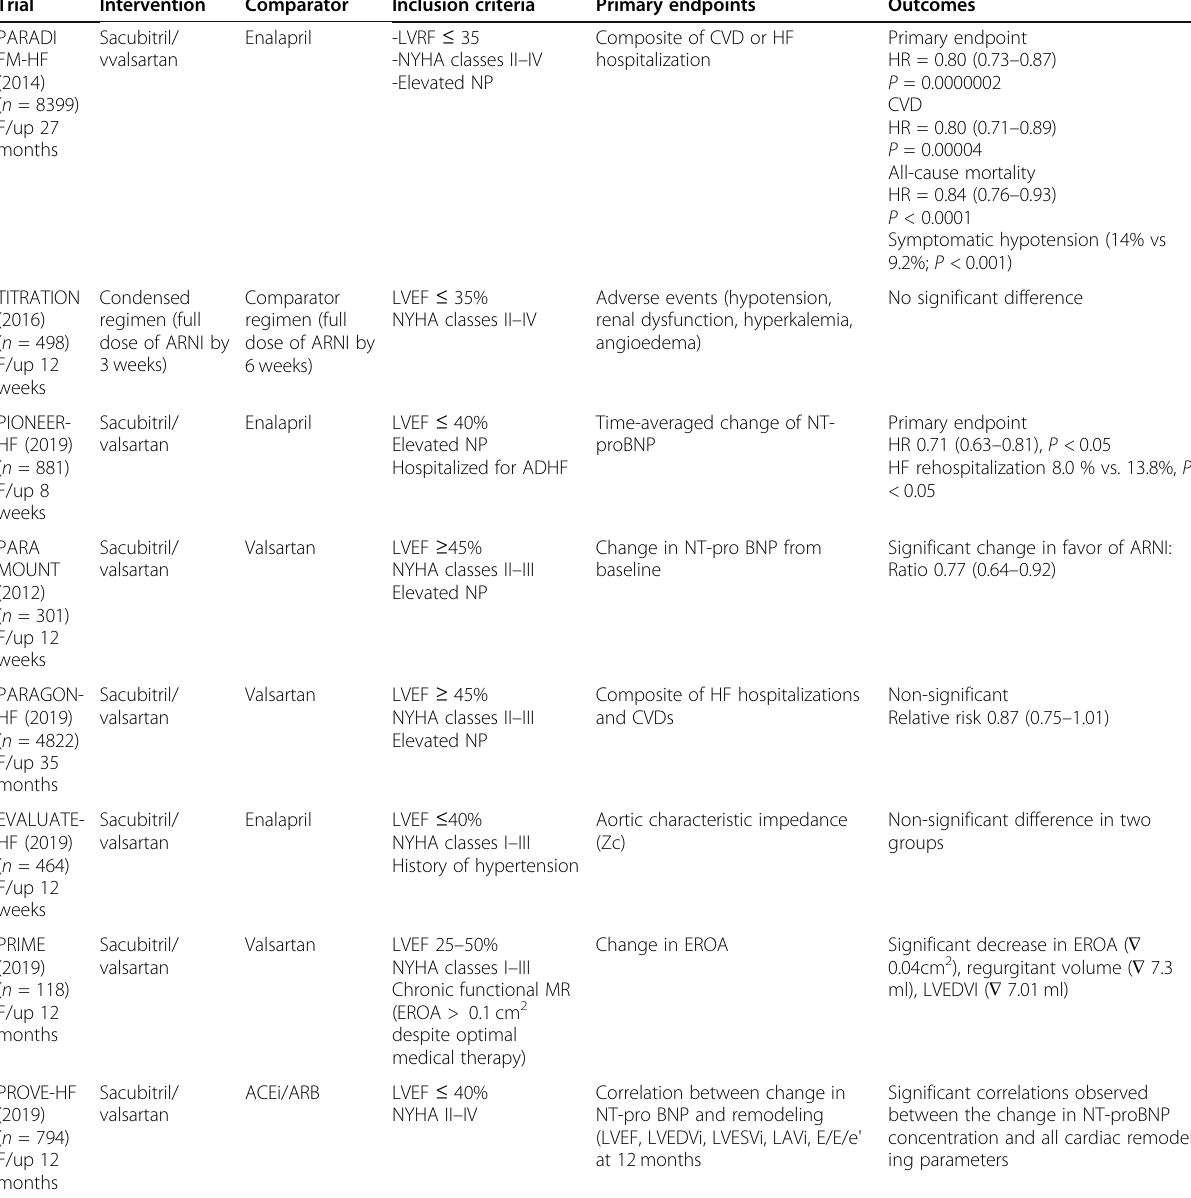
Table 1 Summary of major randomized controlled trials on angiotensin receptor neprilysin